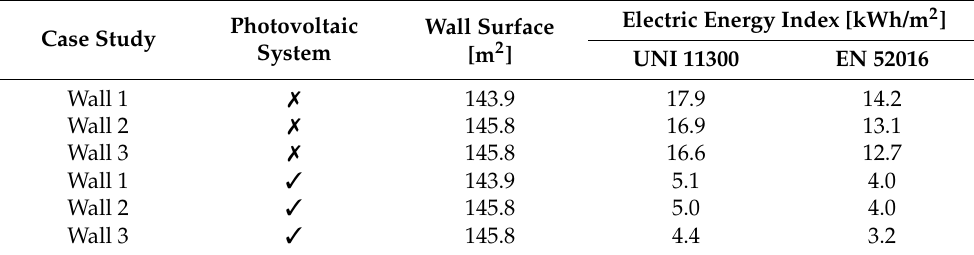
Table 11. Electrical energy index, normalized for the wall